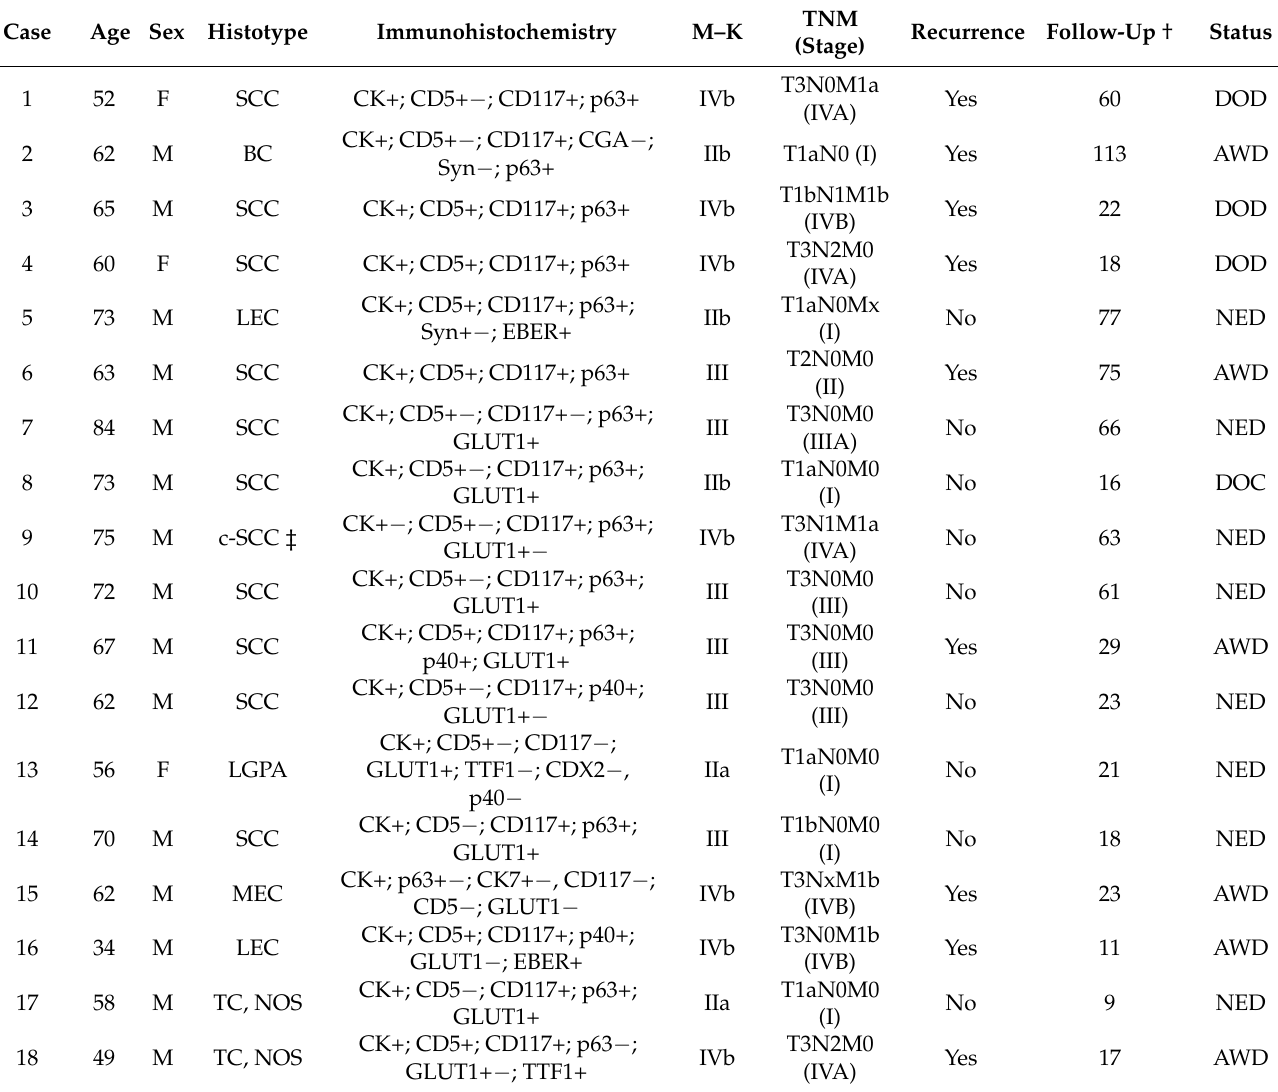
Table 2. Main clinical and histological features of 18 patients with thymic